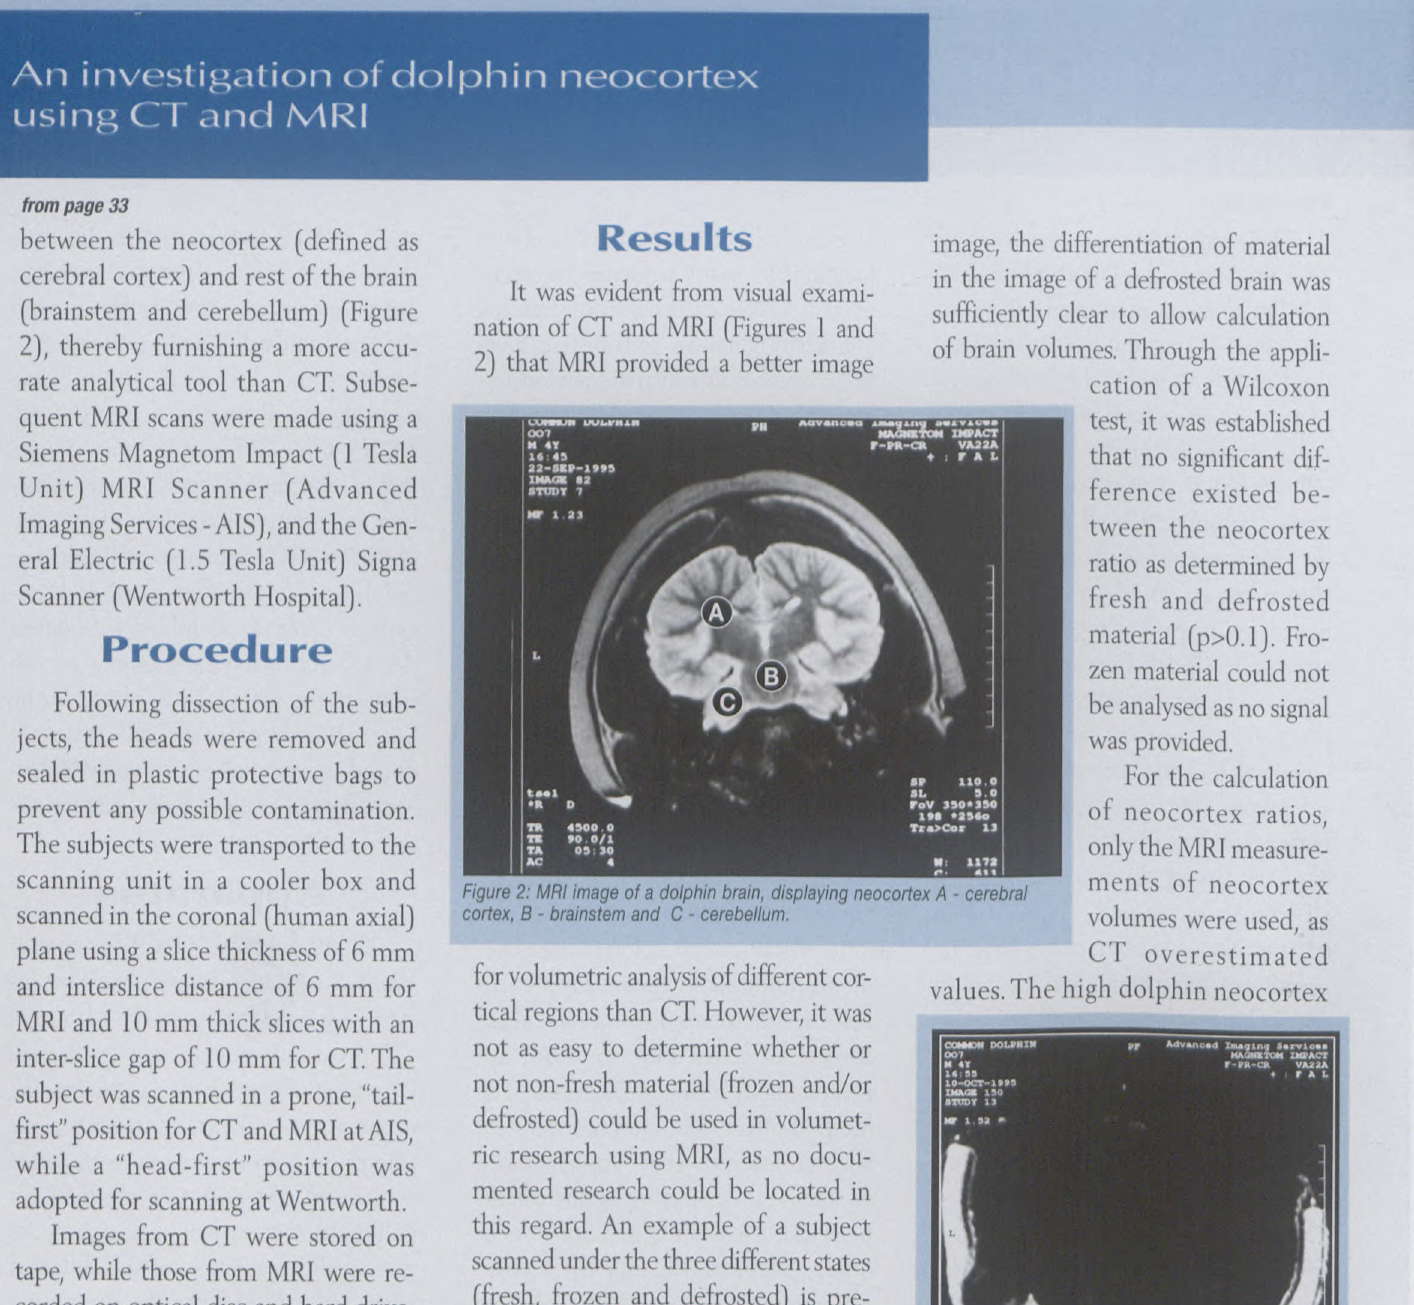
Figure 3: MRI scans of dolphin brain material under various conditions. From a to c: fresh, frozen and